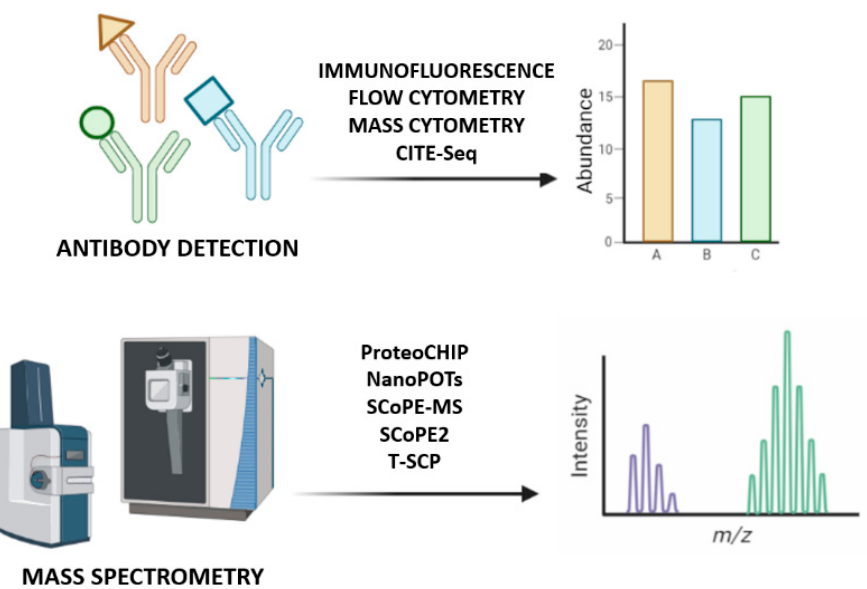
Figure 3. Single-cell proteomics identification methods. At the top of the image, antibodies bind to the epitopes of their proteins and are detected to quantify the corresponding protein; at the bottom, mass spectrometry approaches introduce a non-targeted analysis to identify all proteins based on their mass-to-charge ratio.